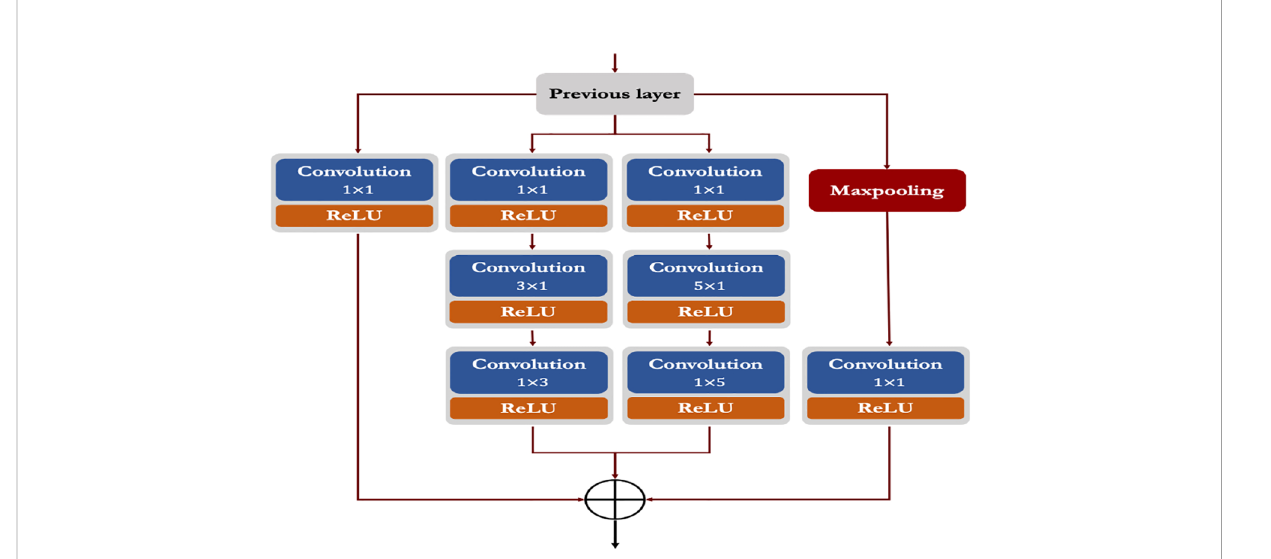
FIGURE 4 Architecture of the proposed modi fi ed inception